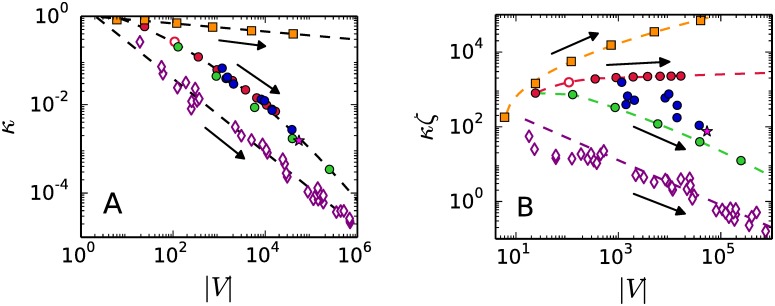
Complexity of the output graphs.A.- By volume size |V| and connectivity κ. B.- By volume size |V| and combined output-input size κζ. The arrows—in all figures—point to larger values of the input size ζ.